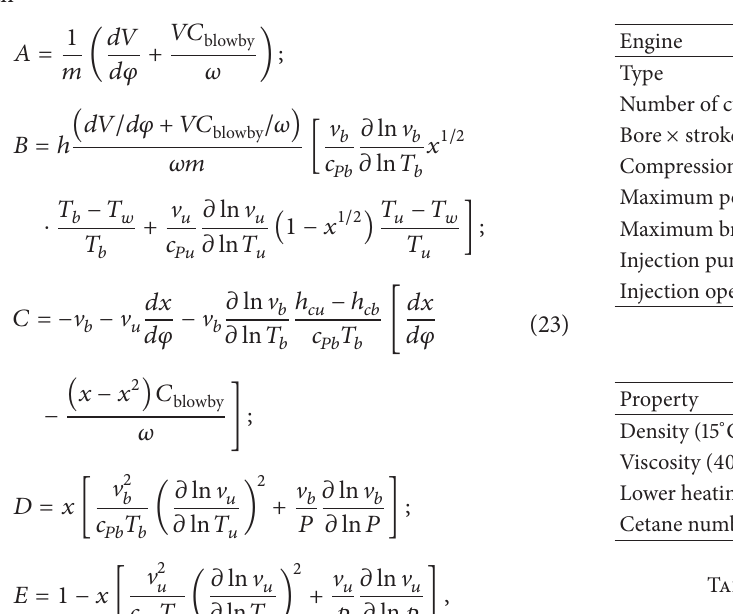
Table 1: Engine specification [32].